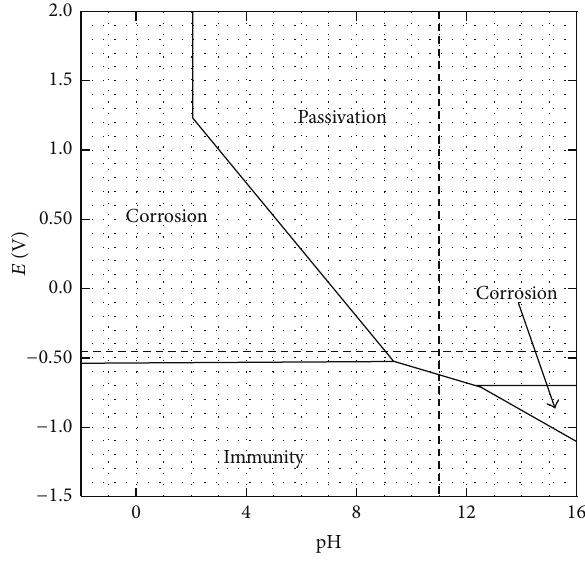
Figure 21: Pourbaix diagram of rebar.